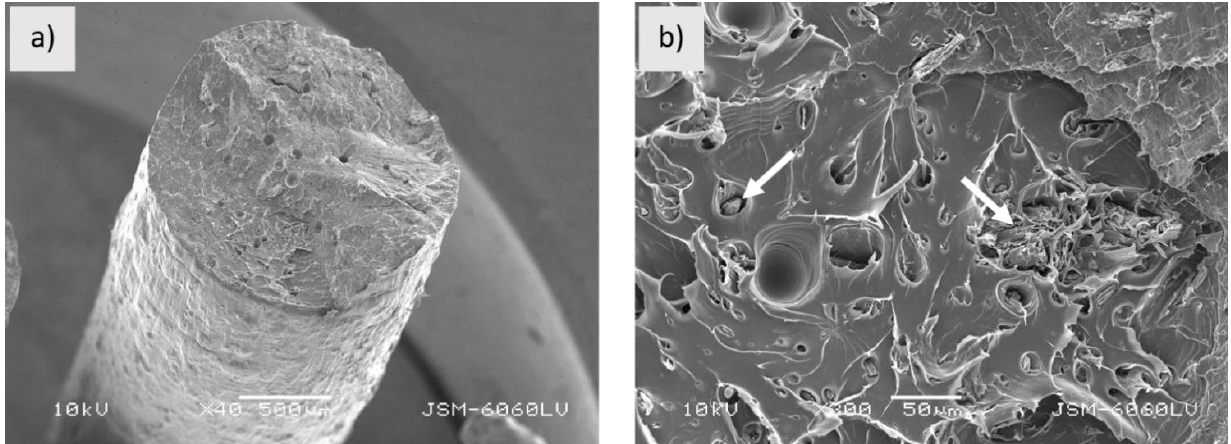
Figure 3. Sample PLA-Entwined_f; ( a ) fractured surface (mag. 40×), ( b ) gaps between matrix and hemp fibres (pointed by arrows) (mag. 1200×).